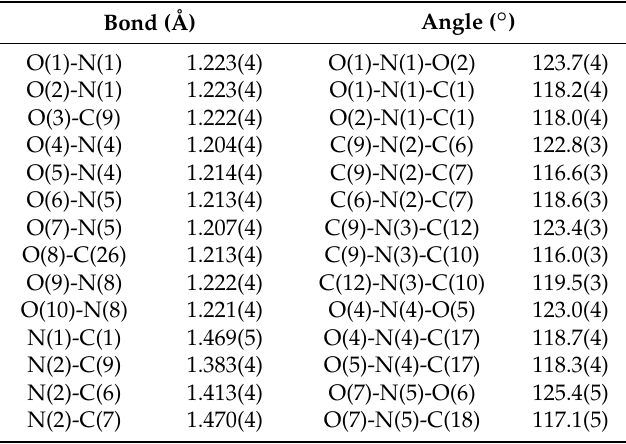
Table 1. Selected bond lengths ( Å ) and bond angles (°).